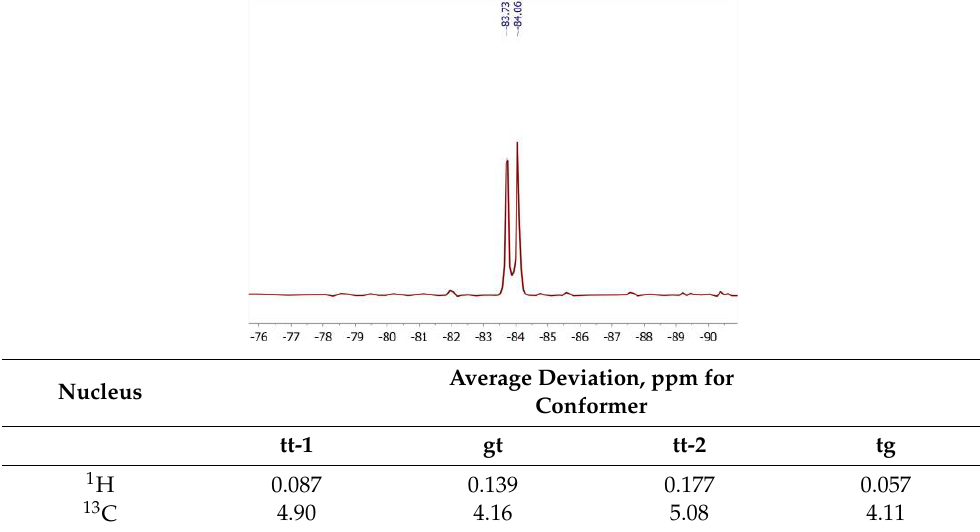
Table 2. 15 N NMR spectrum of CPDA in CDCl 3 and average total deviations of the calculated values of the 1 H and 13 C chemical shifts of the conformers from the experimental ones.